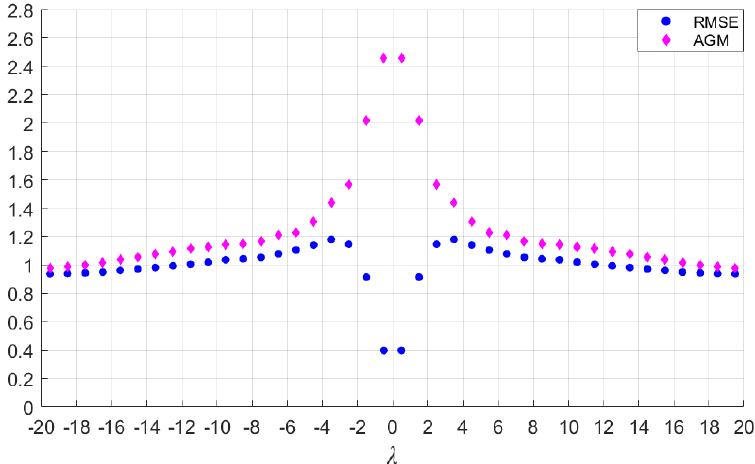
Figure 4. RMSE and AGM of CT images reconstructed by basic filters with different λ ( λ = 1/2 + ν and ν ∈ Z ).